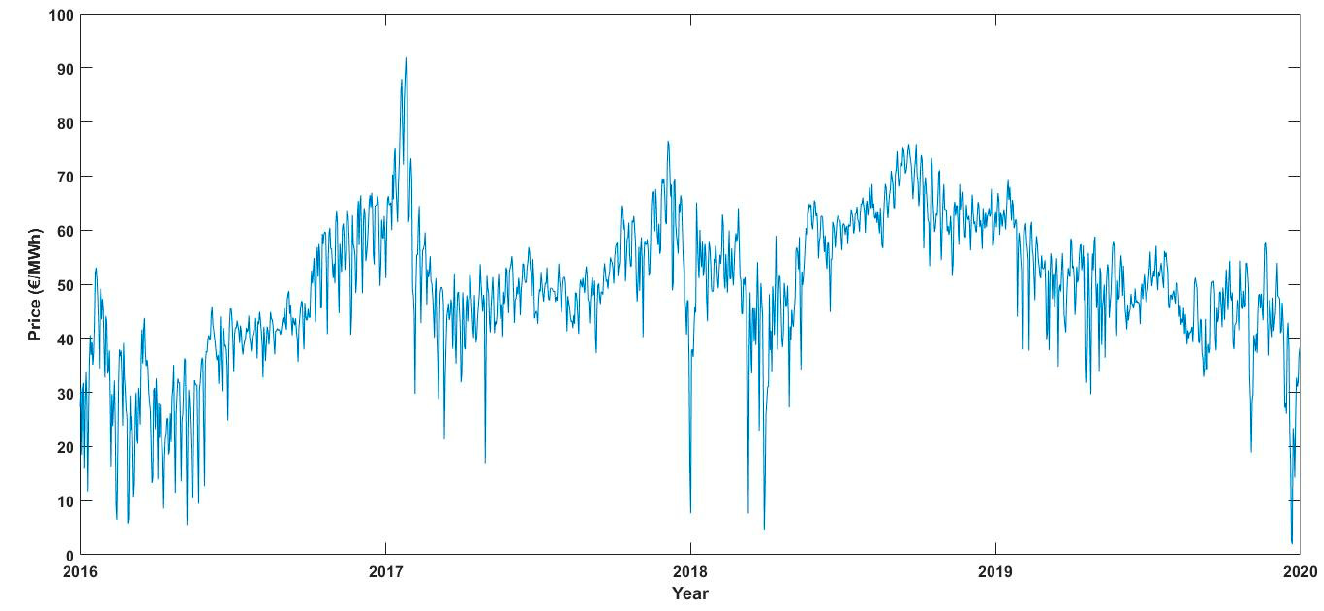
Figure 5. Spanish daily electricity prices from 2016 to 2019.